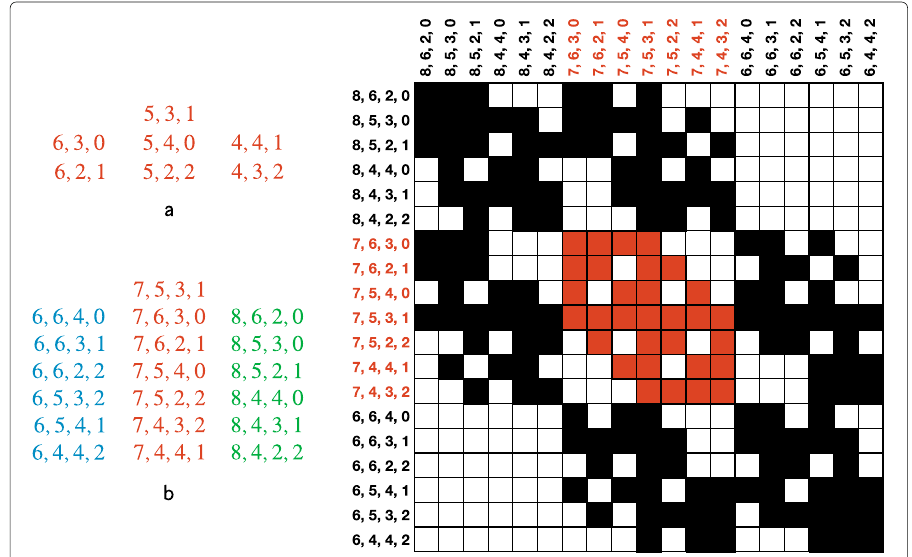
Fig. 5 An example of the adjacency matrix design. A set of ( 16,4 ) -partitions ϑ( 16,4 ) (b), and its adjacency matrix for G ( V ϑ( 16,4 ) , E 4 ) (c). The red squares correspond to the adjacency matrix for G ( V ϑ( 9,3 ) , E 3 ) . At each step (increasing in partition parts m on a unit basis), each adjacency matrix from the previous step becomes the central part of the new matrix for m +